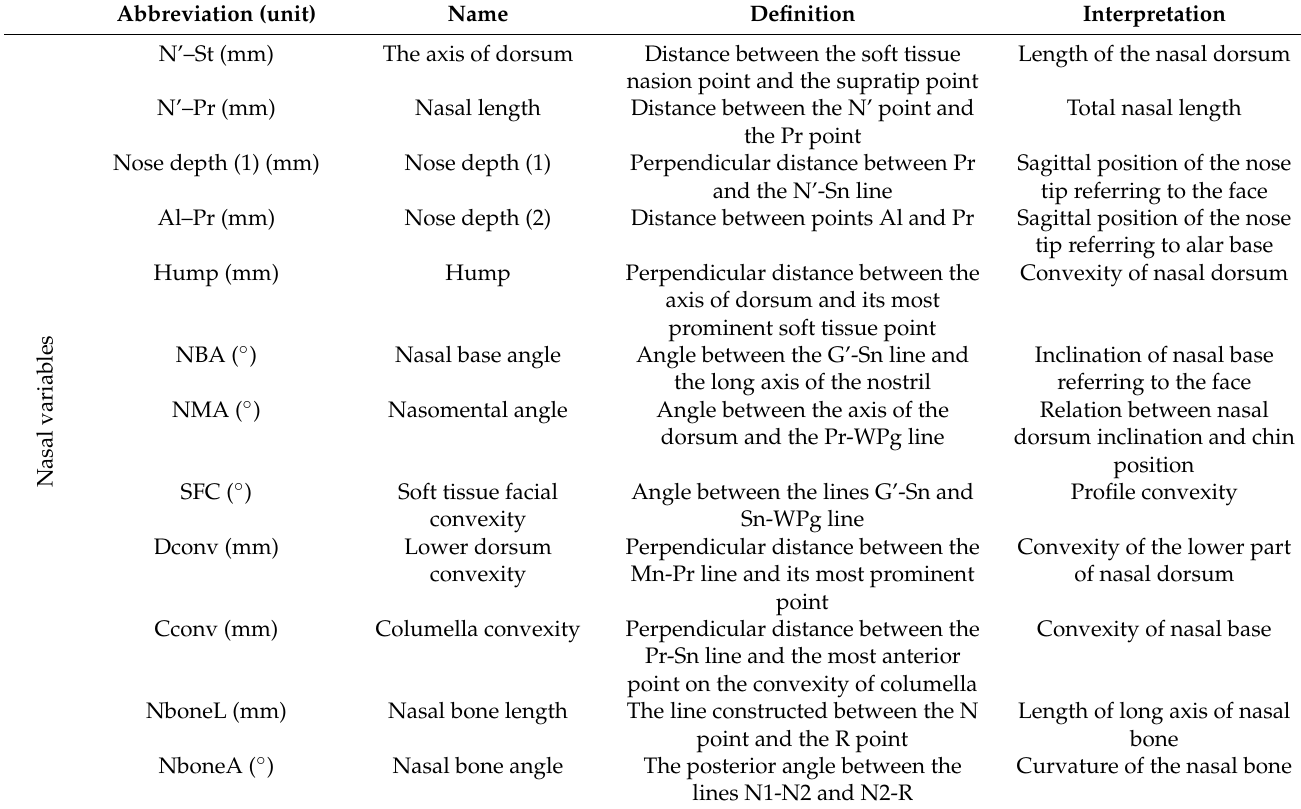
Table 2. Cephalometric and nasal